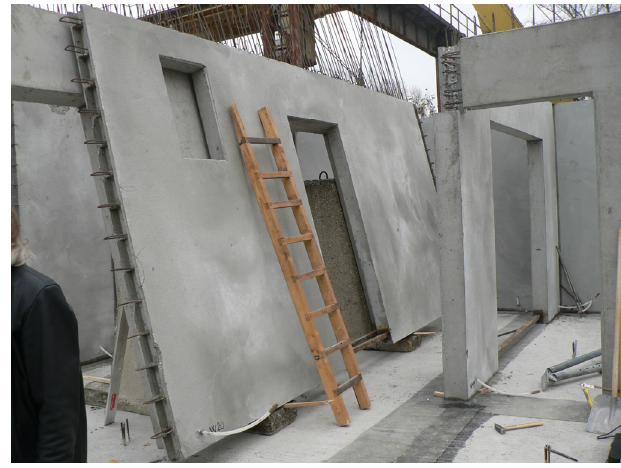
Figure 10. View of reinforced concrete panels with integrated ATP piping. (Photo archive: Kalús). In the ISOMAX system, the load-bearing central structure is made of 150 mm thick reinforced concrete, which is thermally insulated internally and externally with 75 mm